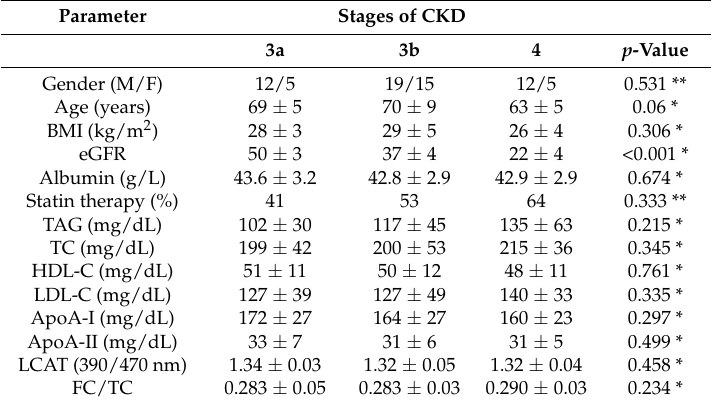
Table 1. Characteristics of patients at various stages of chronic kidney disease